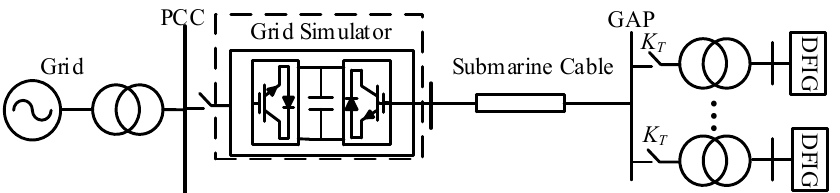
Figure 1. Configuration of the harmonic adaptability (HA) testing system.